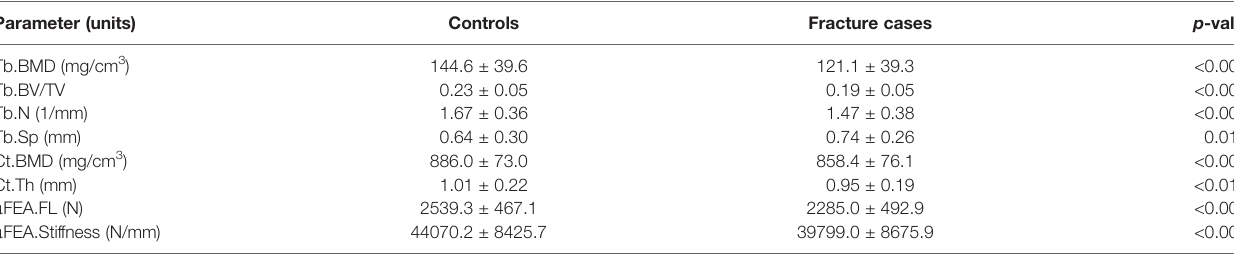
Values are shown as mean ± standard deviation. Linear regression adjusting for age, height, and weight. *Signi fi cant at p <